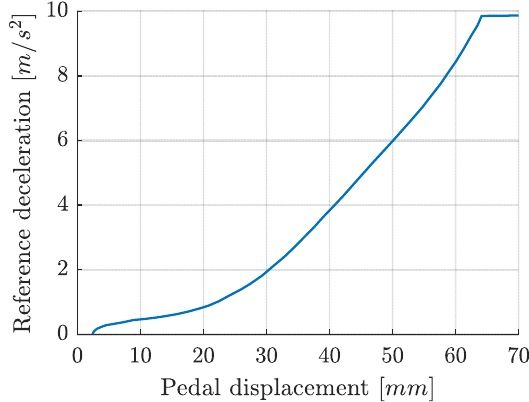
Figure 6. Relation between pedal displacement and reference acceleration.